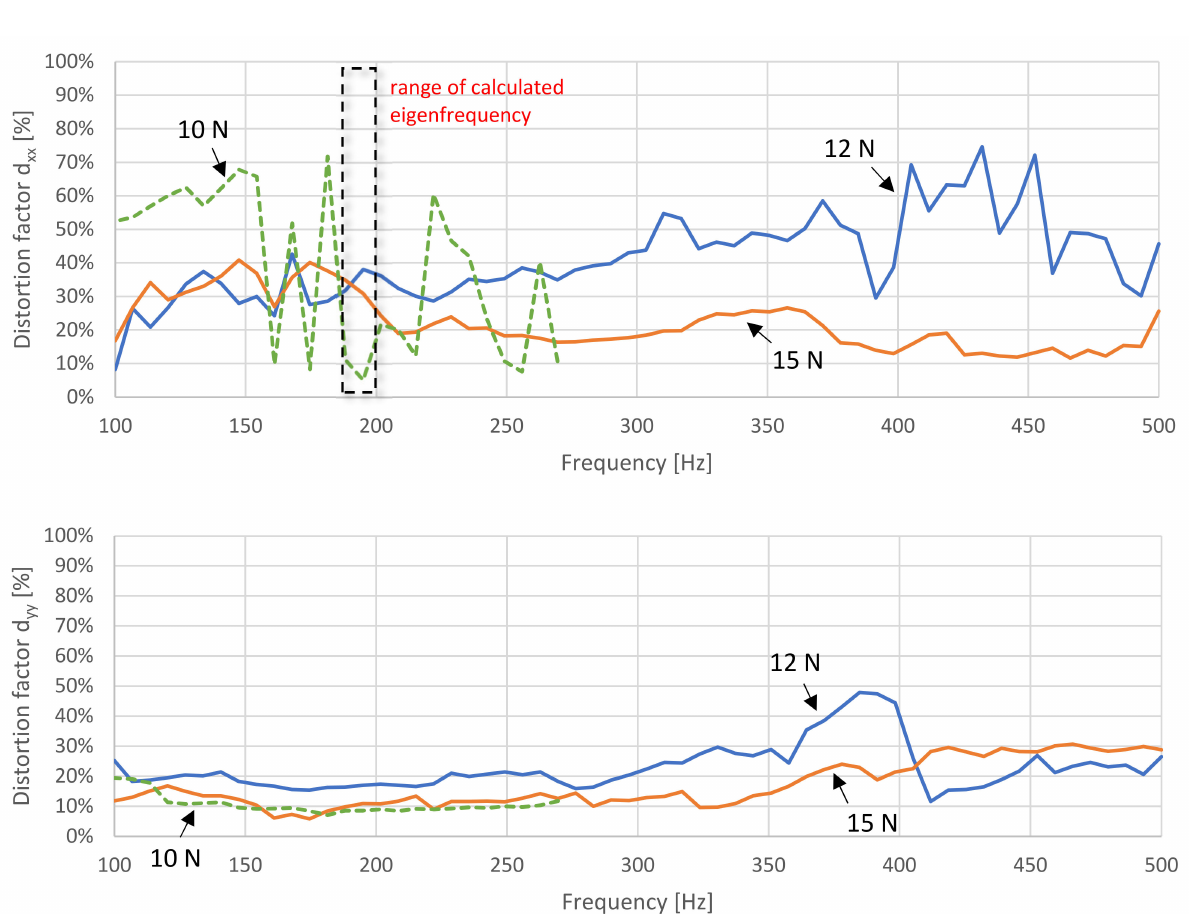
Figure 8. Distortion factors d ln of the pre-tests (11.1 N static